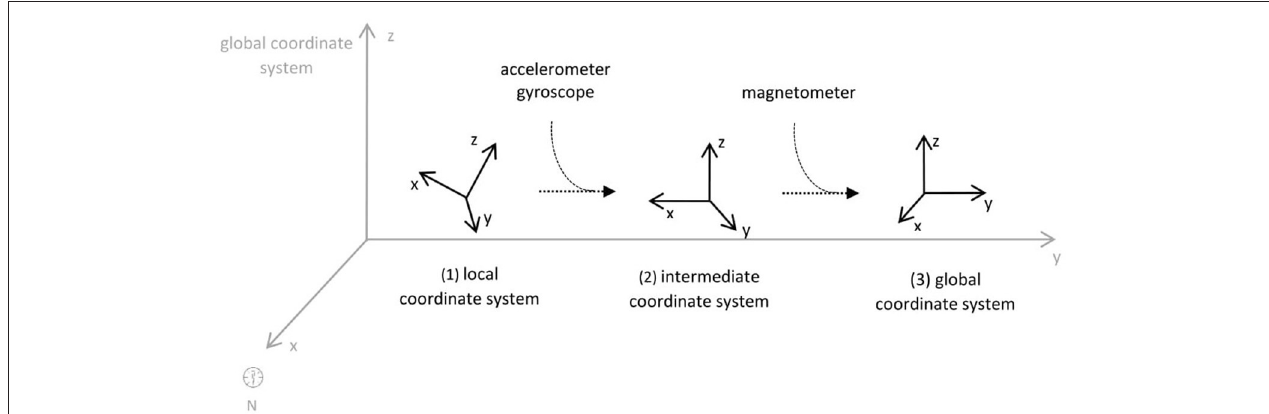
FIGURE 1 | Rotations performed by the CF algorithm with respect to the reference system. The coordinate system in gray represents the GCS with the x-axis pointing toward magnetic north. (1) Represents the orientation of the IMU within the GCS. (2) Result of sensor fusing accelerometer and gyroscope data. The horizontal axes are parallel to the earth’s surface but rotation about the z-axis is missing. Including magnetometer data to the calculations results in (3) with the x-axis of the previous LCS being aligned with the GCS. For the aim of this study the LCS (1) has only been rotated into the intermediate coordinate system